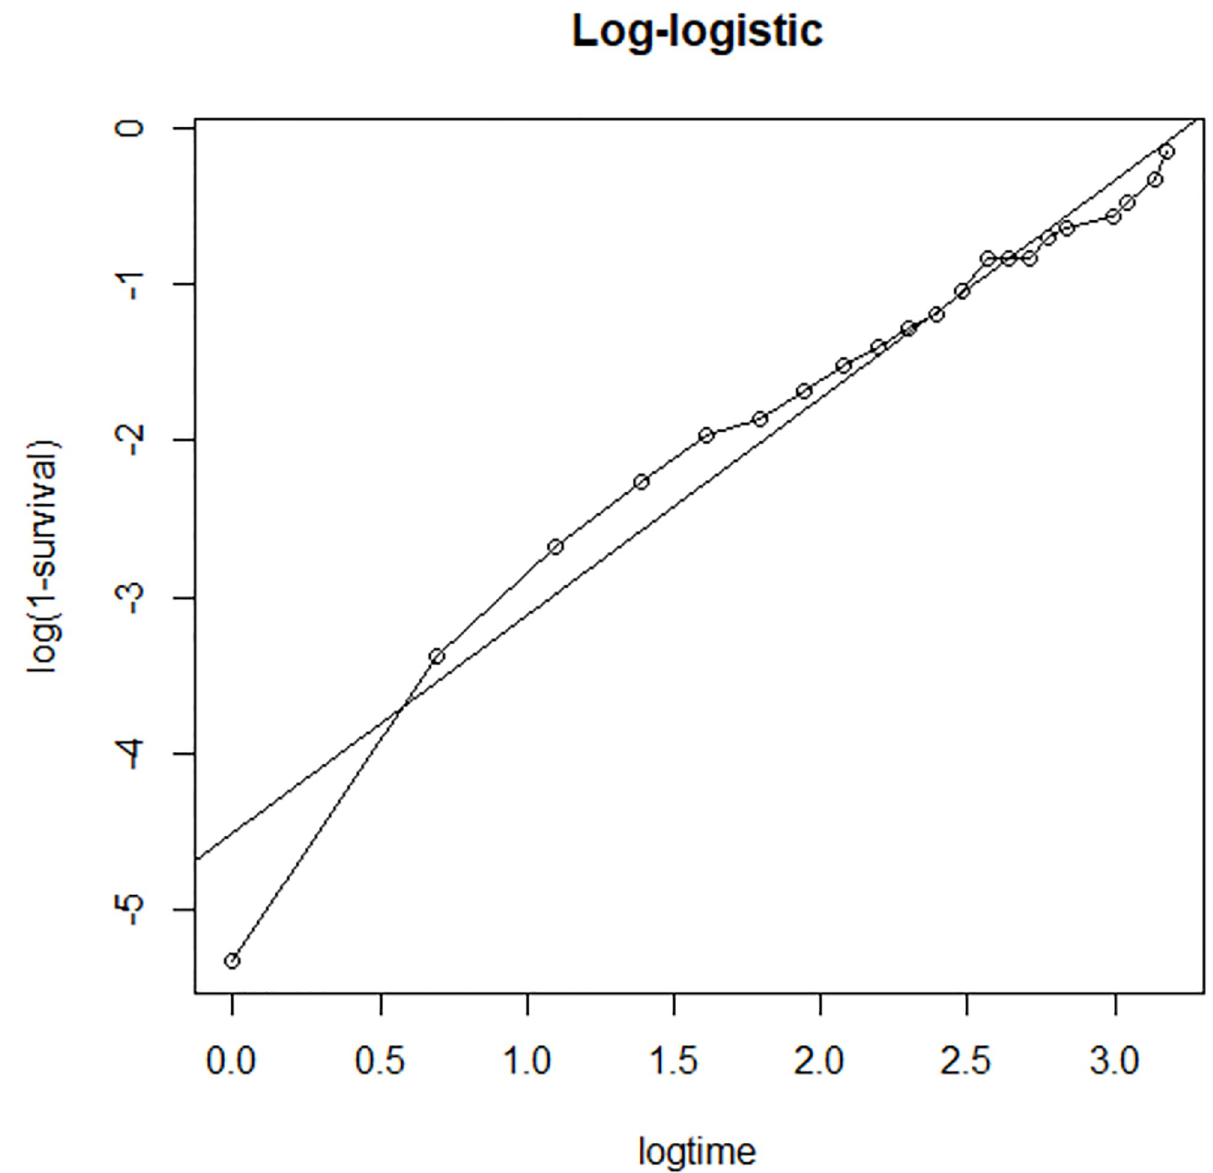
Fig 8. Adequacy checking for the parametric log-logistic baseline distribution, LPAC, 2015–2019.